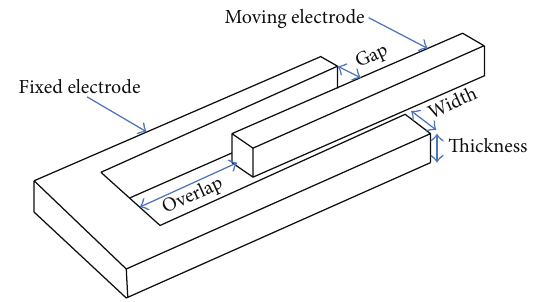
Figure 2: The schematic view of a unit conventional comb drive actuator. All dimensions are represented in 𝜇